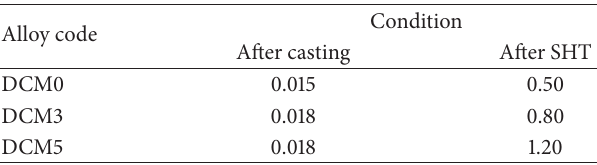
Table4: Porosityvolumefraction(%)measuredinthethreestudied